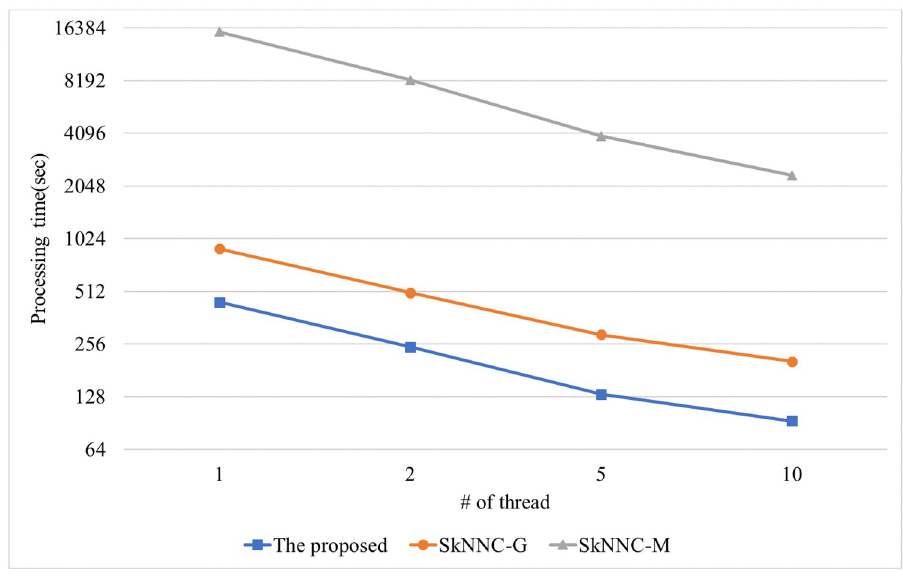
Fig 13. Processing time with varying the number of